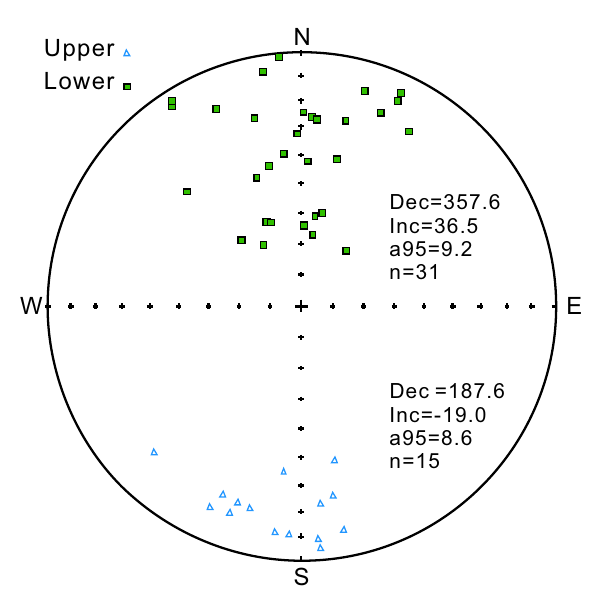
Figure 7. Characteristic remanent magnetization in stratigraphic coordinates. The solid and open symbols represent the lower and upper hemisphere projection, respectively. Dec: declination; Inc: in- clination; a95: radius of cone at 95% confidence level; n : number of data points; all angles are in